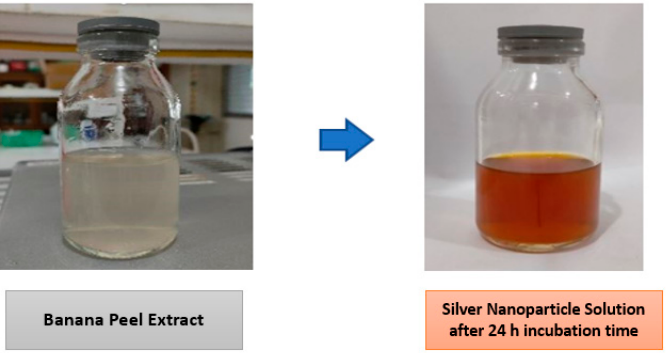
Figure 3. The color change of silver nitrate solution after adding banana peel extract within 24 h of incubation.